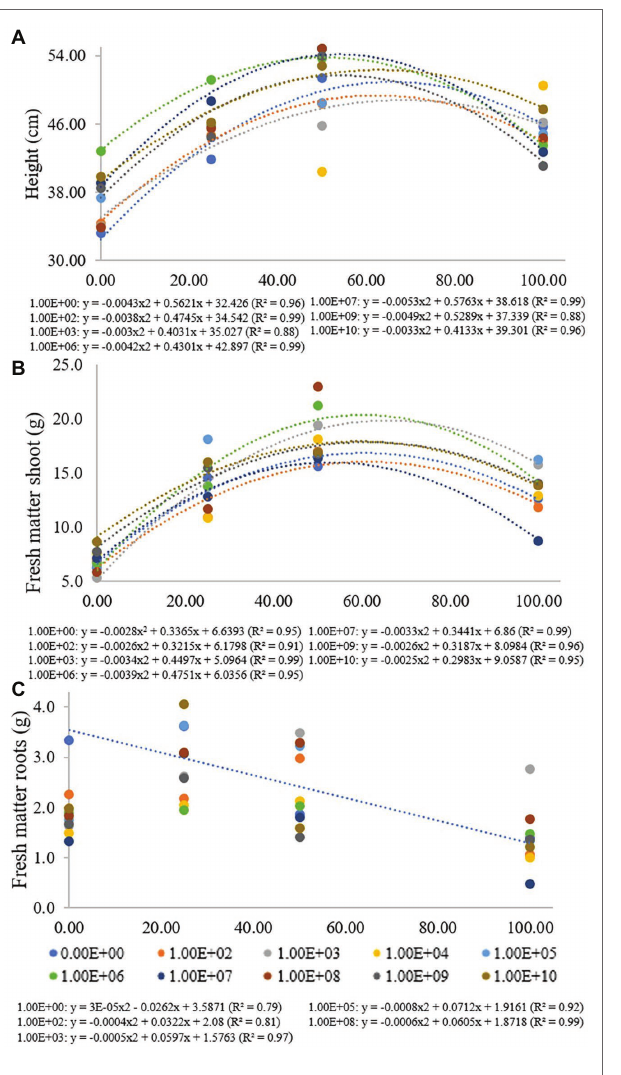
FIGURE 1 | Regression data for the unfolding of the interaction between inoculum concentrations and fertilization doses in relation to (A) plant height, (B) shoot fresh matter and (C) root fresh matter. The X-axis indicates the fertilization dose as a percentage. Colored circles and the equation— 0.00E+00 means no inoculation (control); 1.00E+02 means 1 × 10 2 CFU ml − 1 ; 1.00E+03 means 1 × 10 3 CFU ml − 1 ; 1.00E+04 means 1 × 10 4 CFU ml − 1 ; 1.00E+05 means 1 × 10 5 CFU ml − 1 ; 1.00E+06 means 1 × 10 6 CFU ml − 1 ; 1.00E+07 means 1 × 10 7 CFU ml − 1 ; 1.00E+08 means 1 × 10 8 CFU ml − 1 ; 1.00E+09 means 1 × 10 9 CFU ml − 1 ; and 1.00E+10 means 1 × 10 10 CFU ml − 1